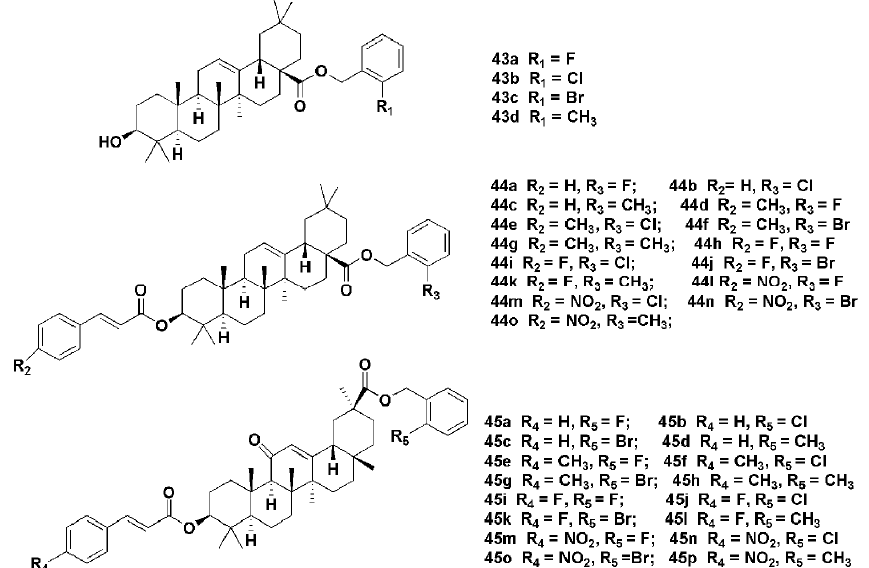
Figure 11. Chemical structures of the novel novel oleanolic acid (OA)-cinnamic acid ester derivatives ( 43a–d and 44a–o ) and glycyrrhetinic acid (GA)-cinnamic acid ester derivatives ( 45a–p ) [5]. ( 43a-d and 44a-o ) and glycyrrhetinic acid (GA)-cinnamic acid ester derivatives ( 45a-p ) [5].